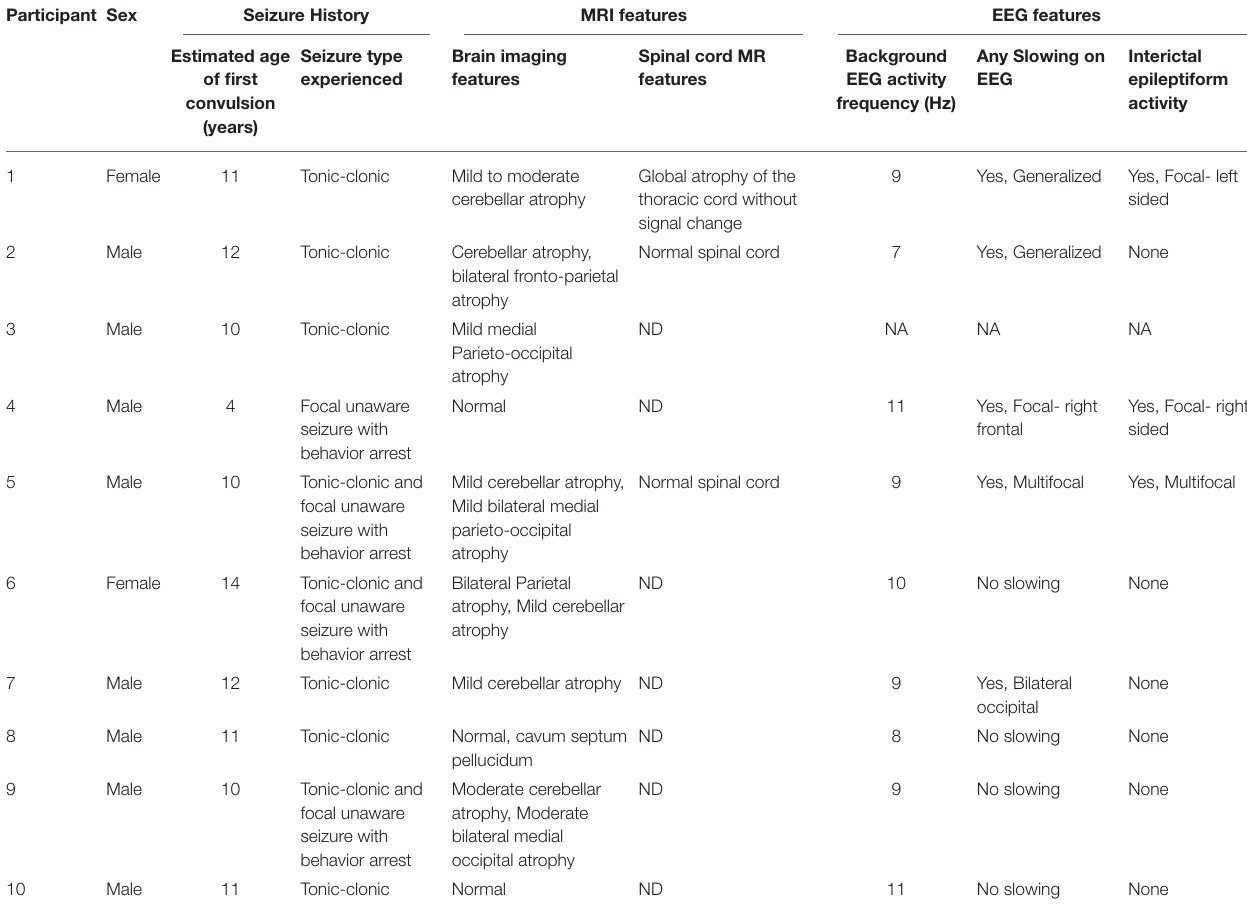
TABLE 2 | Summary of brain imaging and EEG features of children who received an MRI